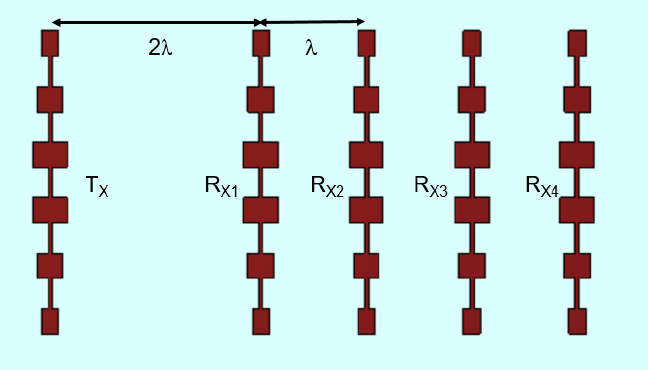
Figure 5. Schematic of the TX/RX antenna array.